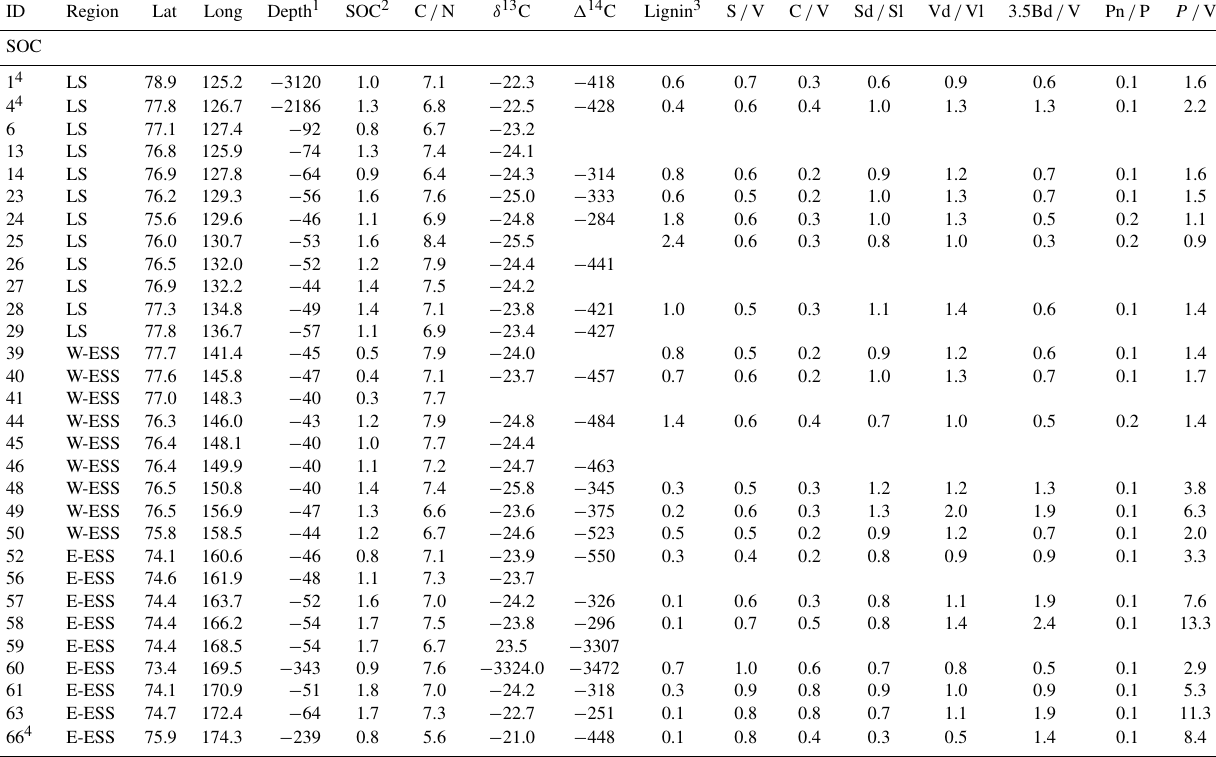
Table 3. Composition of surface sediment samples collected in the outer Eurasian Arctic